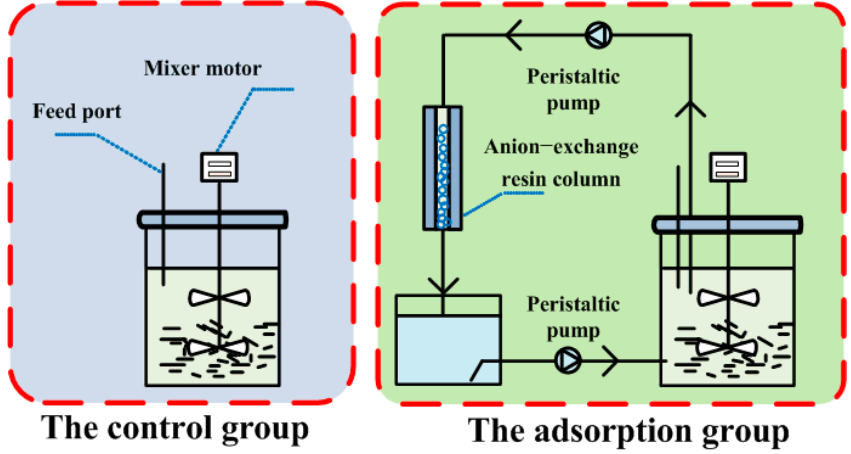
Figure 1. The schematic diagram of the control group and the adsorption group reactors.